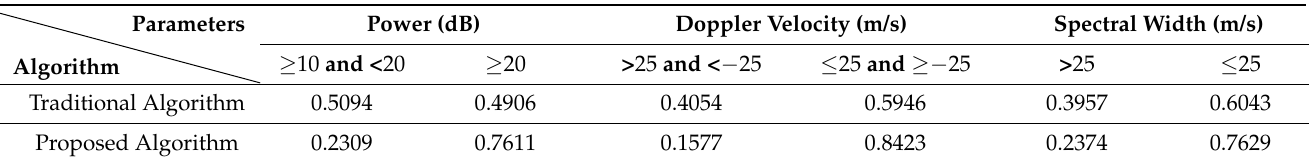
Table 5. Comparison of the incidence of meteor echo between the traditional algorithm and the proposed algorithm under different parameter